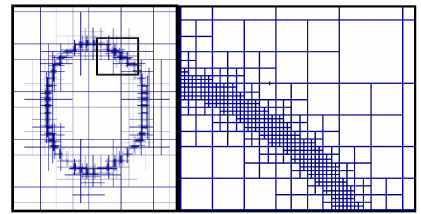
Figure 4. Adaptive grid on the interface.